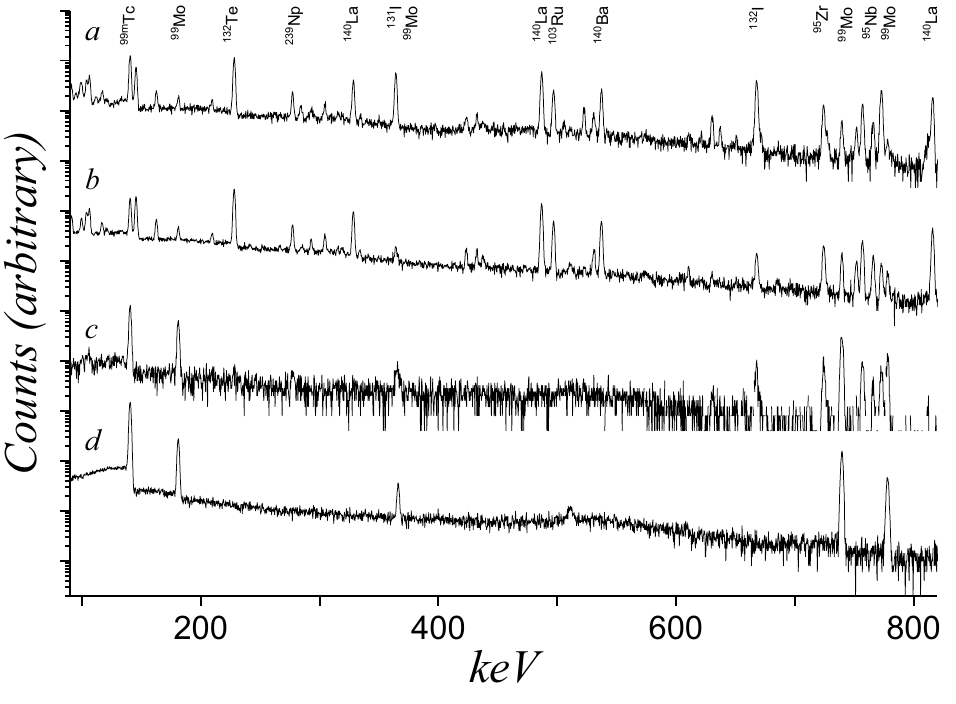
Figure 3. HPGe spectra of the ( a ) UREX feed, ( b ) MoLLE feed, ( c ) concentration column feed, and the ( d ) 99 Mo product derived from the irradiated uranyl sulfate target (LEU). For clarity only selected isotopes are labelled. Spectra were collected at varying count times.